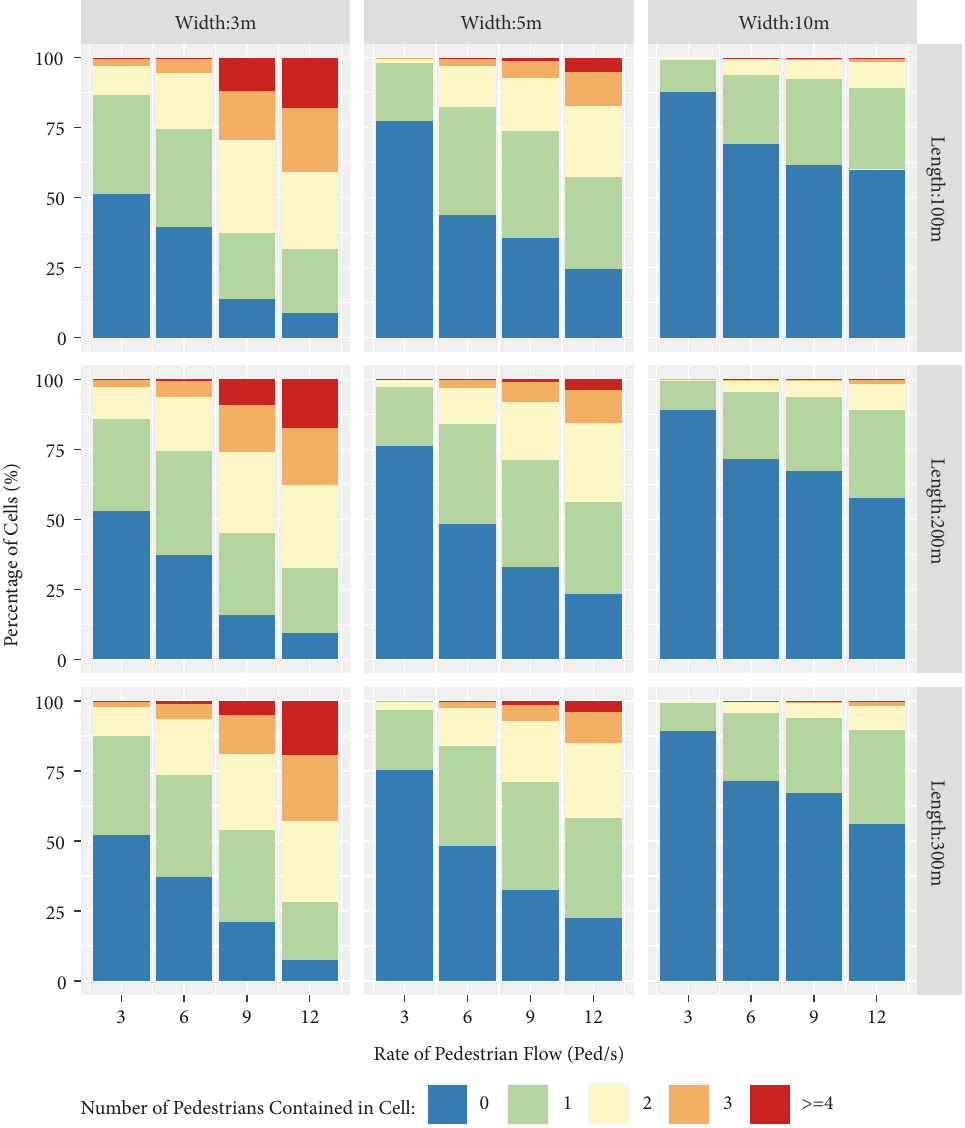
Figure 10: Pedestrian flow distributions in different